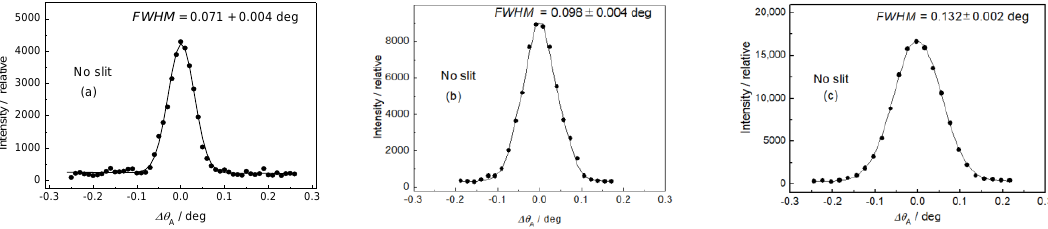
Figure 4. Rocking curves for the annealed α -Fe(110) low-carbon steel rods in vertical position: ( a ) ϕ = 2, ( b ) 4.9, and ( c ) 8 mm.